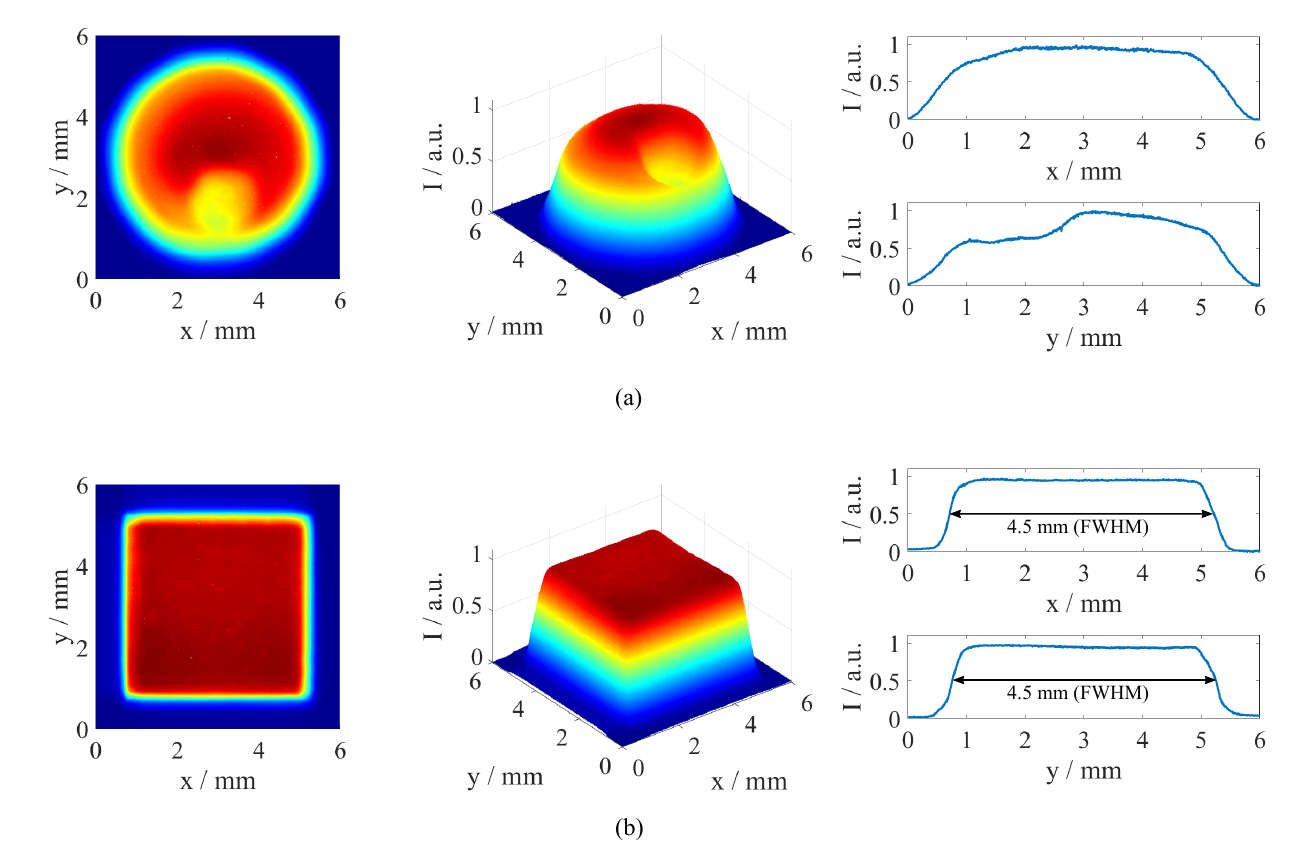
Figure 5. 2D, 3D and cross-sectional intensity profiles of the halogen light source ( a ) after the iris diaphragm and ( b ) after beam homogenization with the fabricated lens arrays. Note, intensity has been normalized for a better visibility. Table 2. Characterization parameters of the generated Top-Hat, calculated by the applied laser camera based on ISO 13694:2000(E) for a threshold of